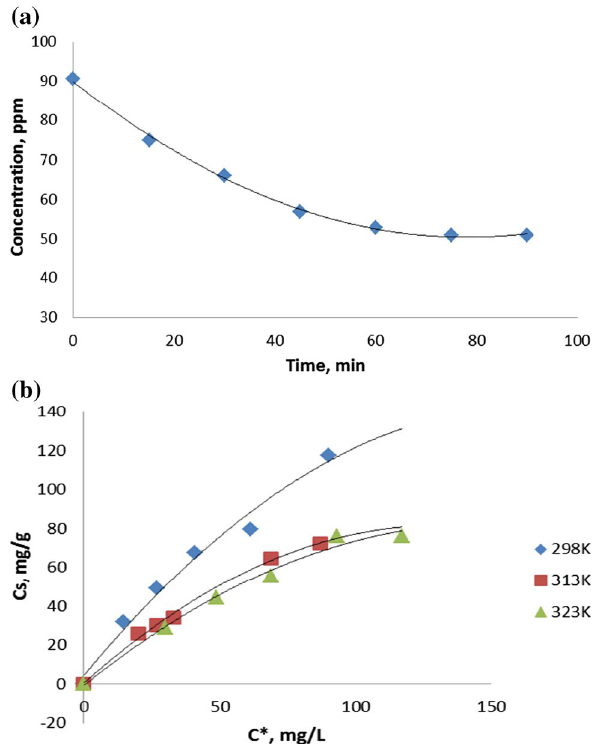
Fig. 5 Effect of contact time and temperature at pH = 5. a Variation of cadmium metal ion with time at pH = 5 and temperature 298 K. b Variation of cadmium metal ion distribution with temperature at pH = 5 and 0.091 g/50